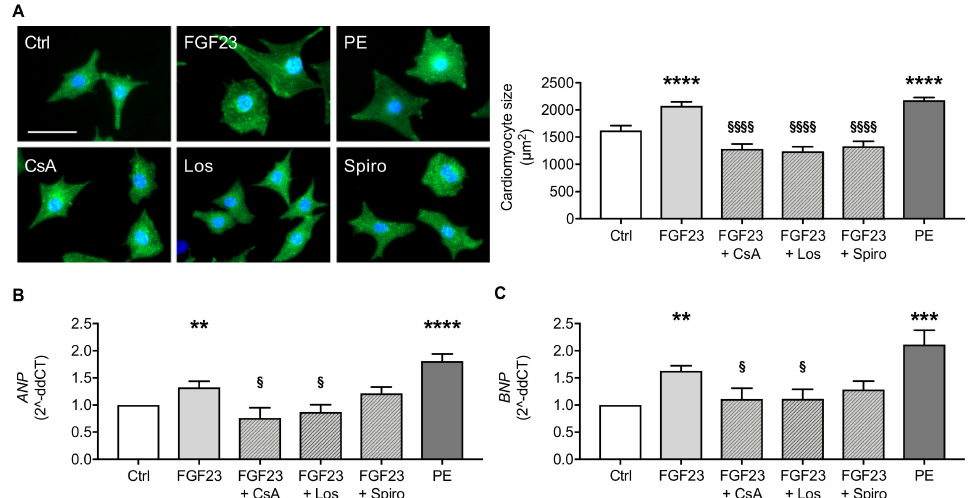
Figure 4. FGF23-induced hypertrophy in cultured NRVM is prevented by cyclosporine A